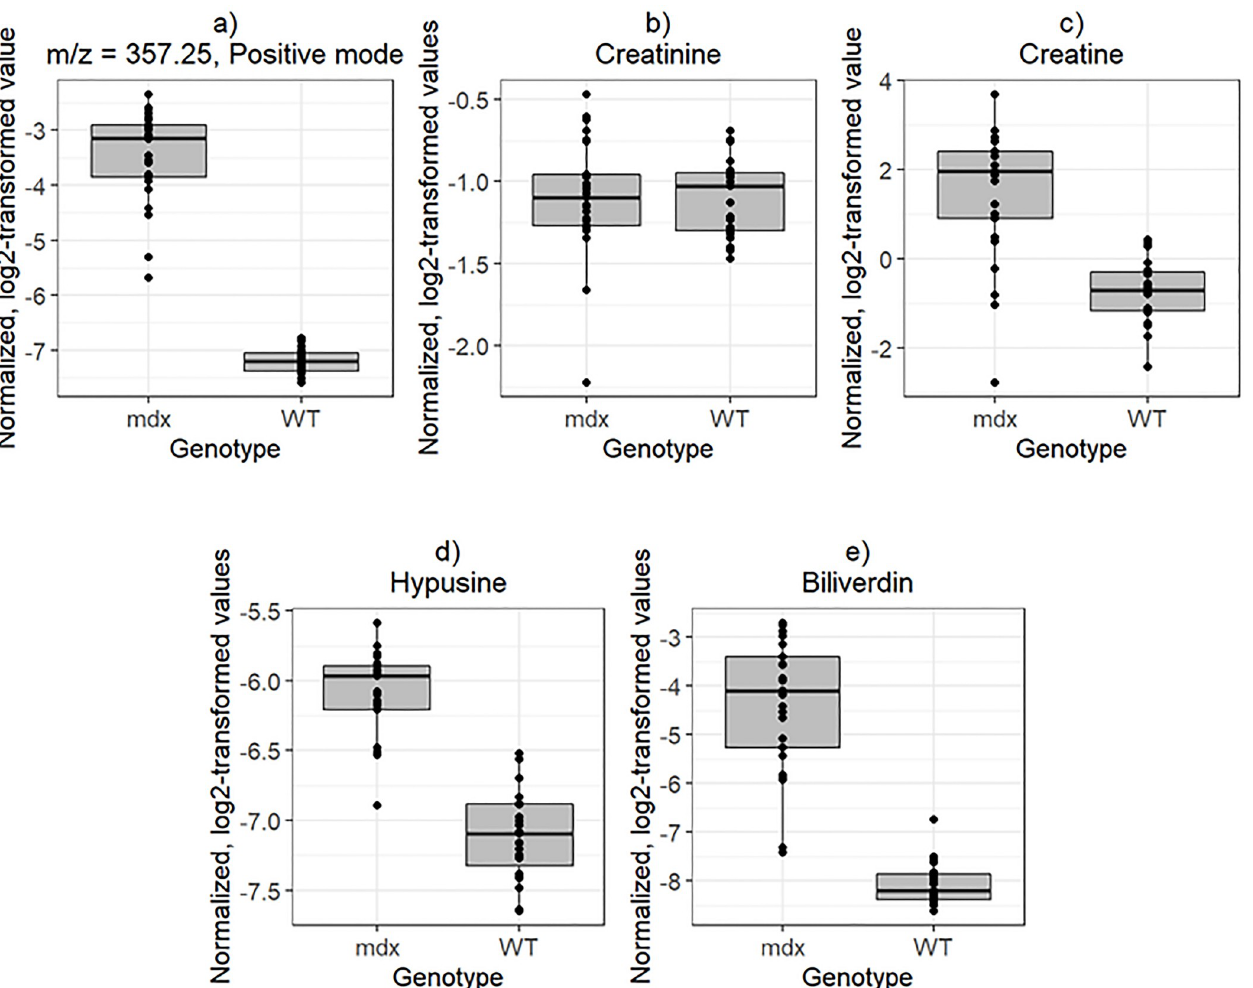
Fig 3. Genotype comparison of normalized, log2-transformed intensity values at baseline (T0). a) peak with m/z = 357.25, b) creatine (m/z = 132.08 in positive mode), c) creatinine (m/z = 114.06 in positive mode), d) hypusine (m/z = 234.18 in positive mode), e) biliverdin (m/z = 583.26 in positive